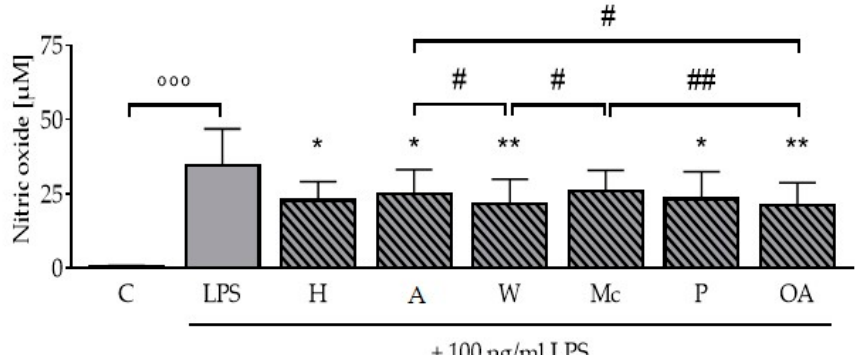
Figure 4. Oily nut extracts (ONE) and oleic acid (OA) decrease formation of nitric oxide in murine RAW264.7 macrophages. RAW264.7 macrophages were incubated as outlined in Figure 1 to perform Griess assays. The incubation with lipopolysaccharides (LPS) led to a significant increase in the production of nitric oxide to 34.7 µ M. ONEs significantly reduced the LPS-induced production of nitric oxide. Error bars display calculated means of five independent biologically replicates performed as two technical replicates. Abbreviations: A, almond; C, control; H, hazelnut; M, macadamia; OA, oleic acid; P, pistachio; W, walnut; Significant differences compared to the untreated control ( ◦◦◦ p < 0.001) and to the LPS control (* p < 0.05, ** p < 0.01) were obtained by one-way ANOVA. # p < 0.05 and ## p < 0.01 represents significant differences between oily nut extracts.